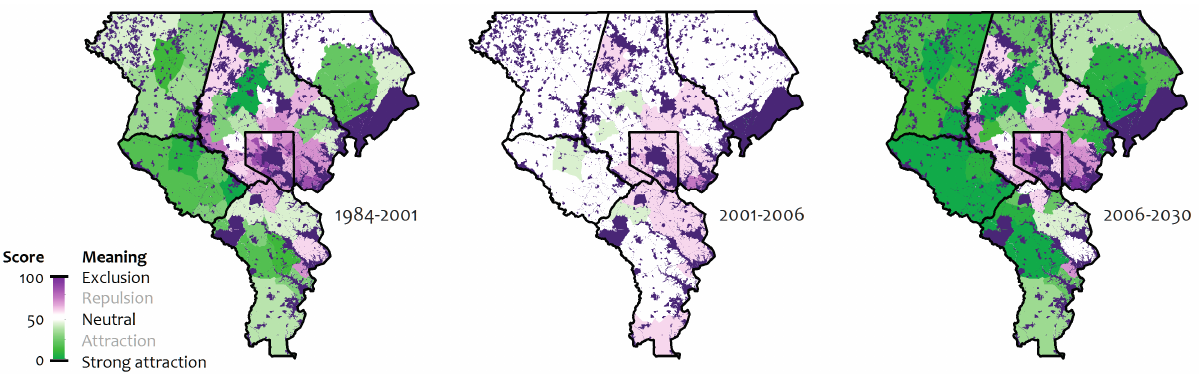
Figure 5. Exclusion/attraction layers derived from BMC-CFG data for the